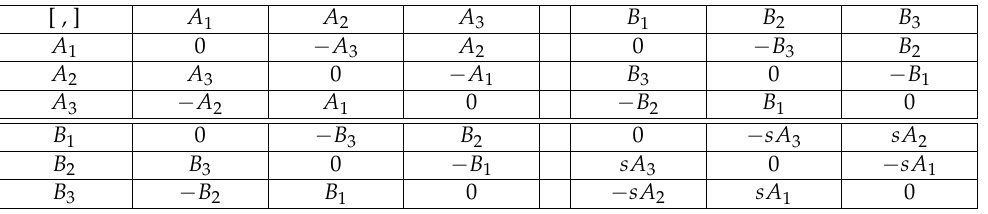
Table 1. Lie brackets for s =